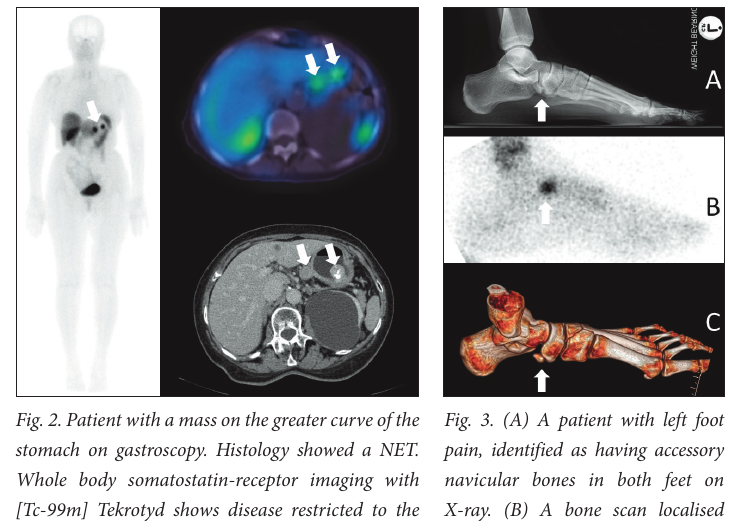
Fig. 3. (A) A patient with left foot pain, identified as having accessory navicular bones in both feet on X-ray. (B) A bone scan localised the pain source to the accessory navicular bone, (C) which is again demonstrated on subsequent a 3D CT reconstruction.